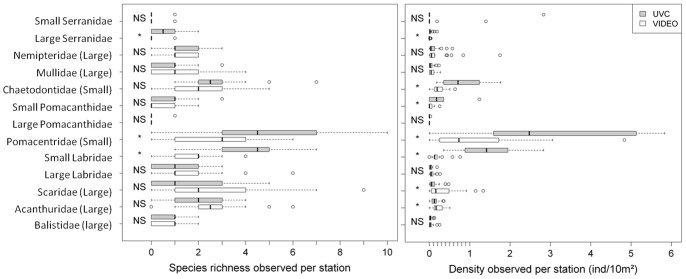
Species richness and density observed per station for the 10 main families observed, distinguishing the size class of the species observed as small or large (see previous paragraph).A size class in brackets indicates that all species observed in the family are characterized by the same size group. The result of the Student t-test on the difference between techniques is reported on the left side of the plot. NS: p>0.05; *: p<0.05.